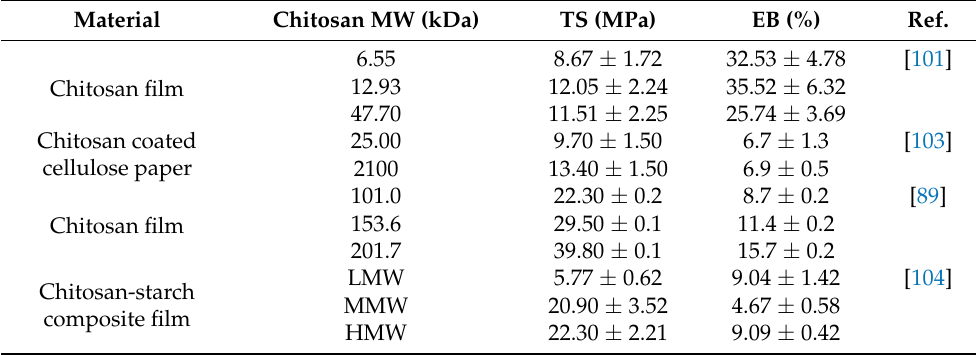
Table 3. Tensile strength (TS) and elongation-at-break (EB) properties of chitosan-materials with different molecular weight (MW)